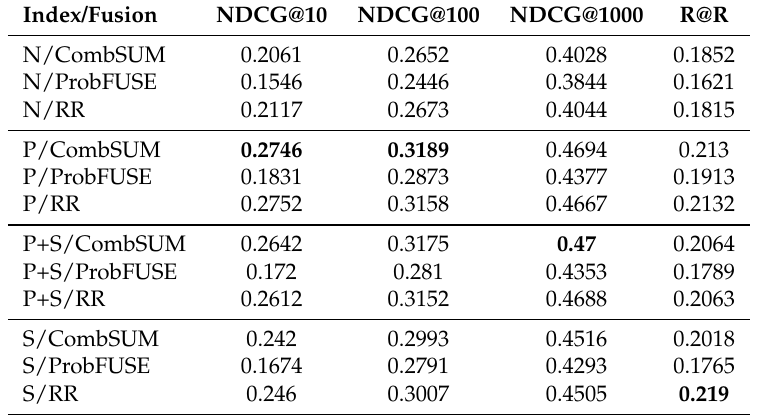
Table 13. T2: NDCG and Recall@R for the fusion runs. The highest values are in